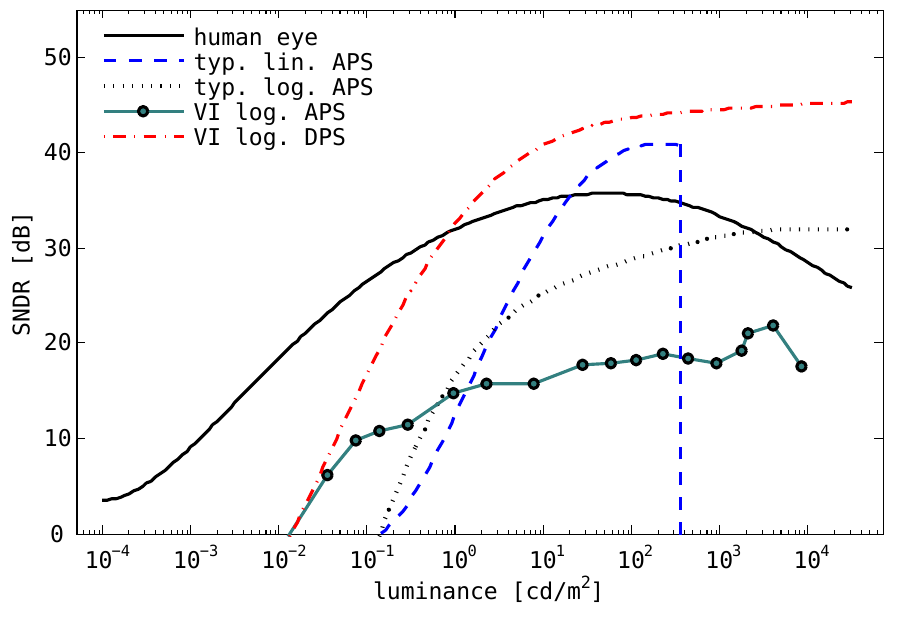
Figure 12. SNDR curves of the human eye, typical linear and logarithmic CMOS APS, and the VI-CMOS APS. The expected curve from a VI-CMOS DPS is also